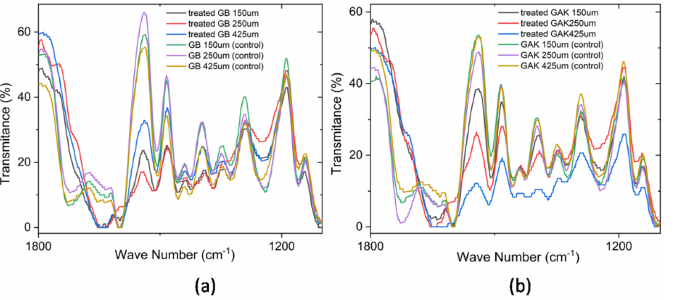
Figure 6. ATR-FTIR results of the giant bamboo (GB) and G. angustifolia Kunt (GAK) fibers at dif- ferent sieves: ( a , c ) the untreated control and ( b , d ) with treatment, respectively. Figure 7 shows the regions of spectra in which collections of characteristic lignin peaks for GB and GAK samples are found. Changes in the intensities of the polymer functional groups were analyzed from each labeled peak as well as those that were re- duced or disappeared due to treatment, within the range of interest 1200 cm − 1 to 1800 cm − 1 . All spectra were placed at the same intensity reference base for comparison.